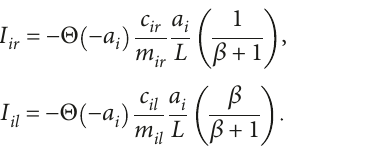
Figure 2: Simulation of the standard symmetric model showing oscillation of (a) left lower and upper masses ( x glottal volume fl ow velocity U